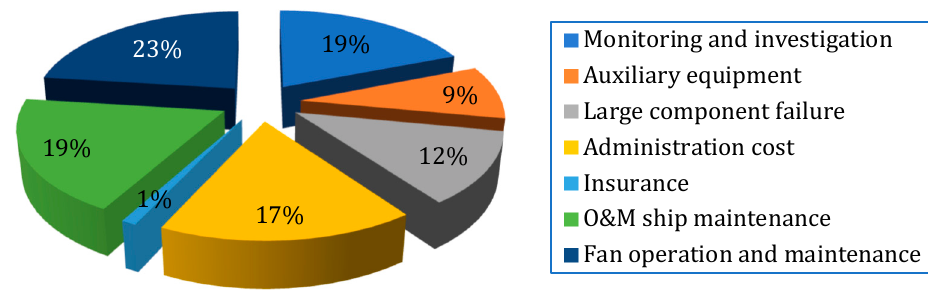
Figure 1. Operation and maintenance cost of offshore wind power.